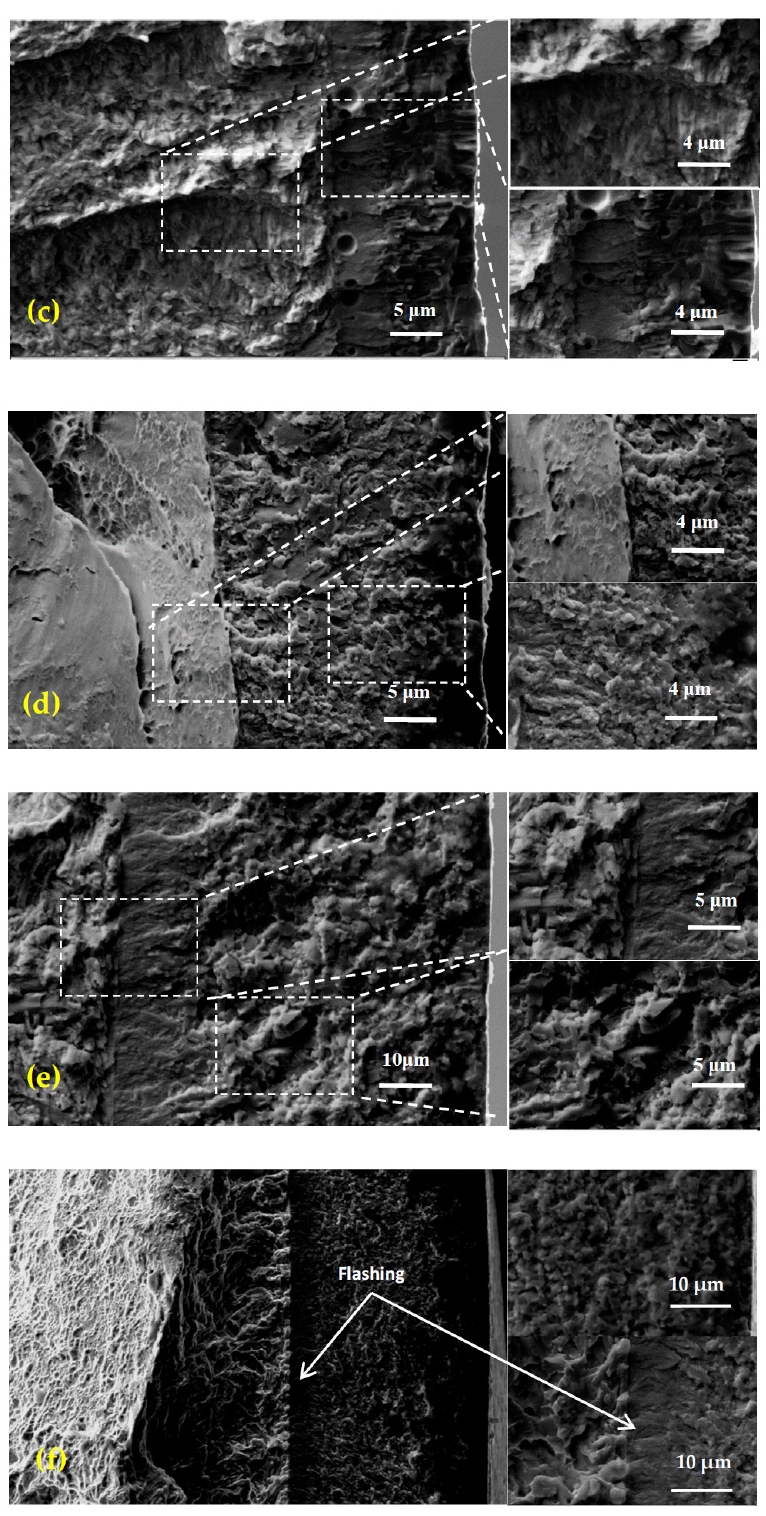
Figure 8. SEM comparison of fatigue fracture of sample No. 1 ( a ), sample No. 2 ( b ), sample No. 3 ( c ), sample No. 4 ( d ), sample No. 5 ( e ), sample No. 6 ( f ).